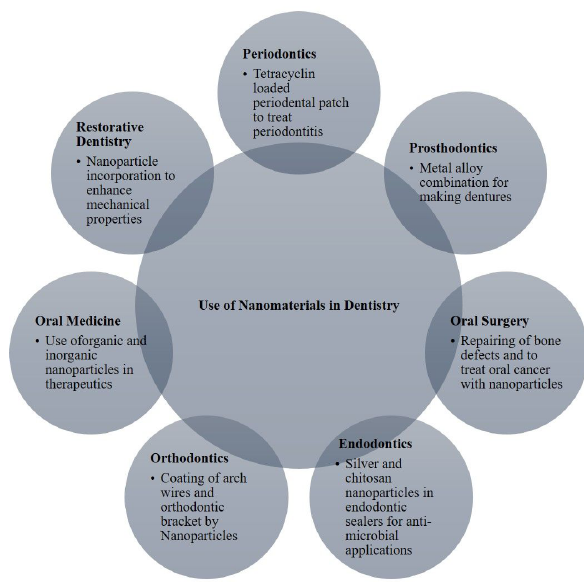
Figure 1: Various applications of Nanomaterials in